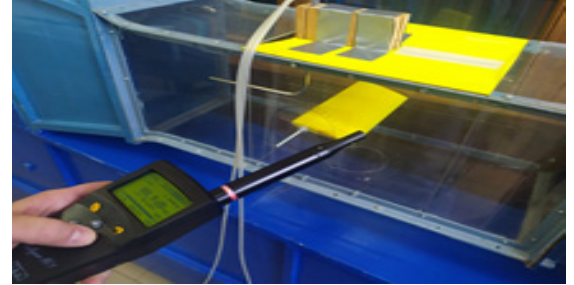
Figure 2. Broadband noise measurement